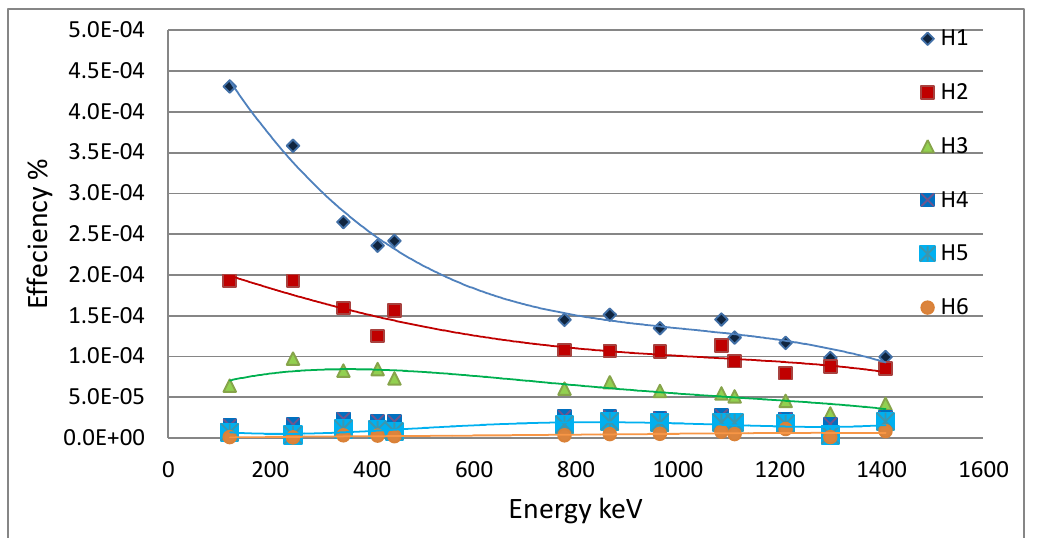
Fig.6: Efficiency curves for six holes (positions) individually for twelve photo peak in polynomial fitting of order